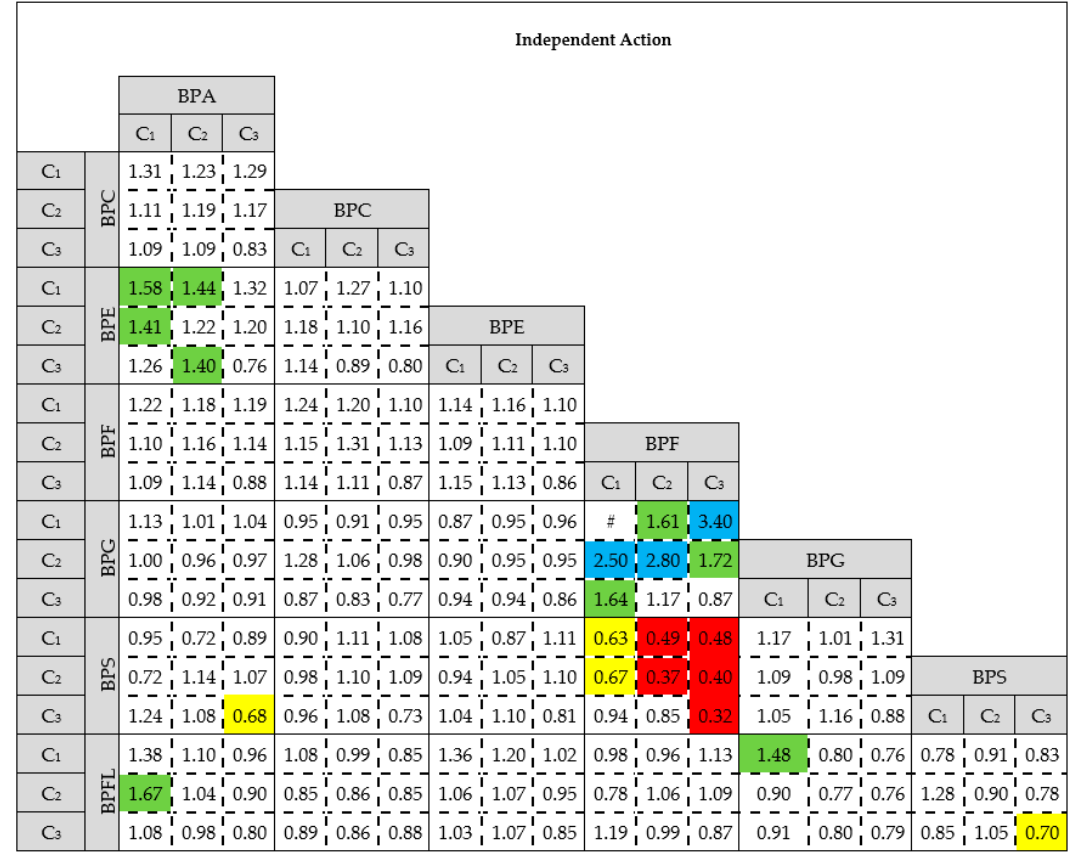
Table 2b. MDR values for bisphenol A analogues binary mixtures toxicity studies performed with Microtox ® assay (for both CA modelling) (red—Synergism, blue—Antagonism, green—Overestimation, yellow—Underestimation, C 1 , C 2 and C 3 stand for 33, 66 and 100% of EC 50 of respective analogue as presented in Table 1. #—data inconclusive).